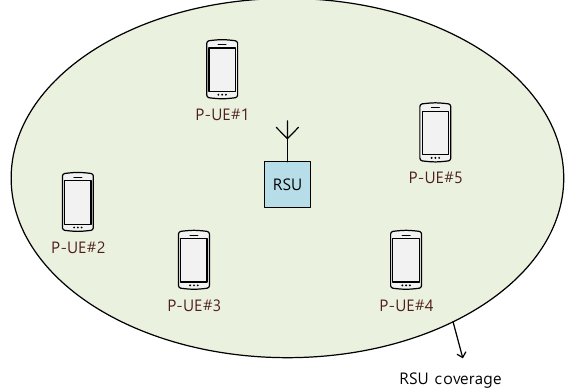
Figure 3. A mode-2 sidelink signal environment consisting of an RSU and P-UEs.